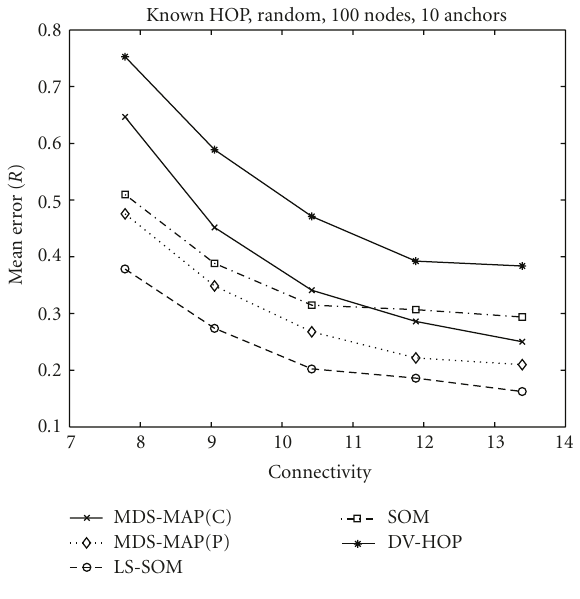
Figure 5: Performace by connectivity.